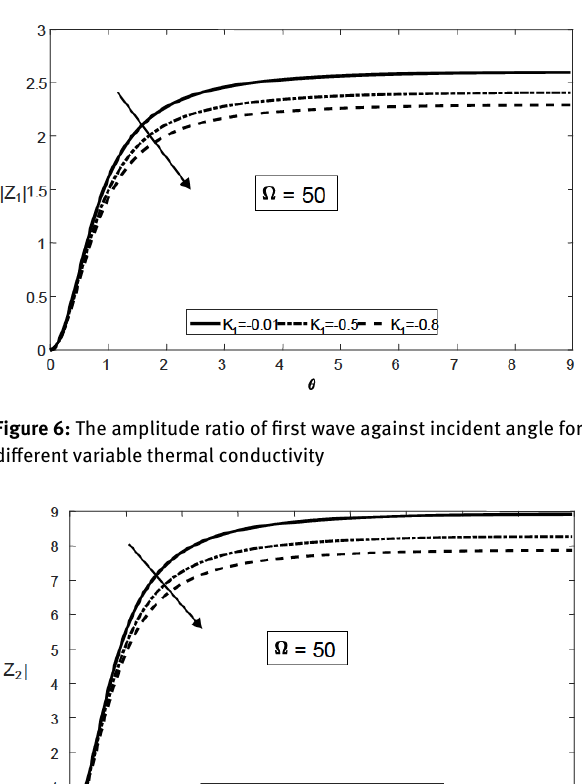
Figure 7: Amplitude ratio of second wave against incident angle for different variable thermal conductivity